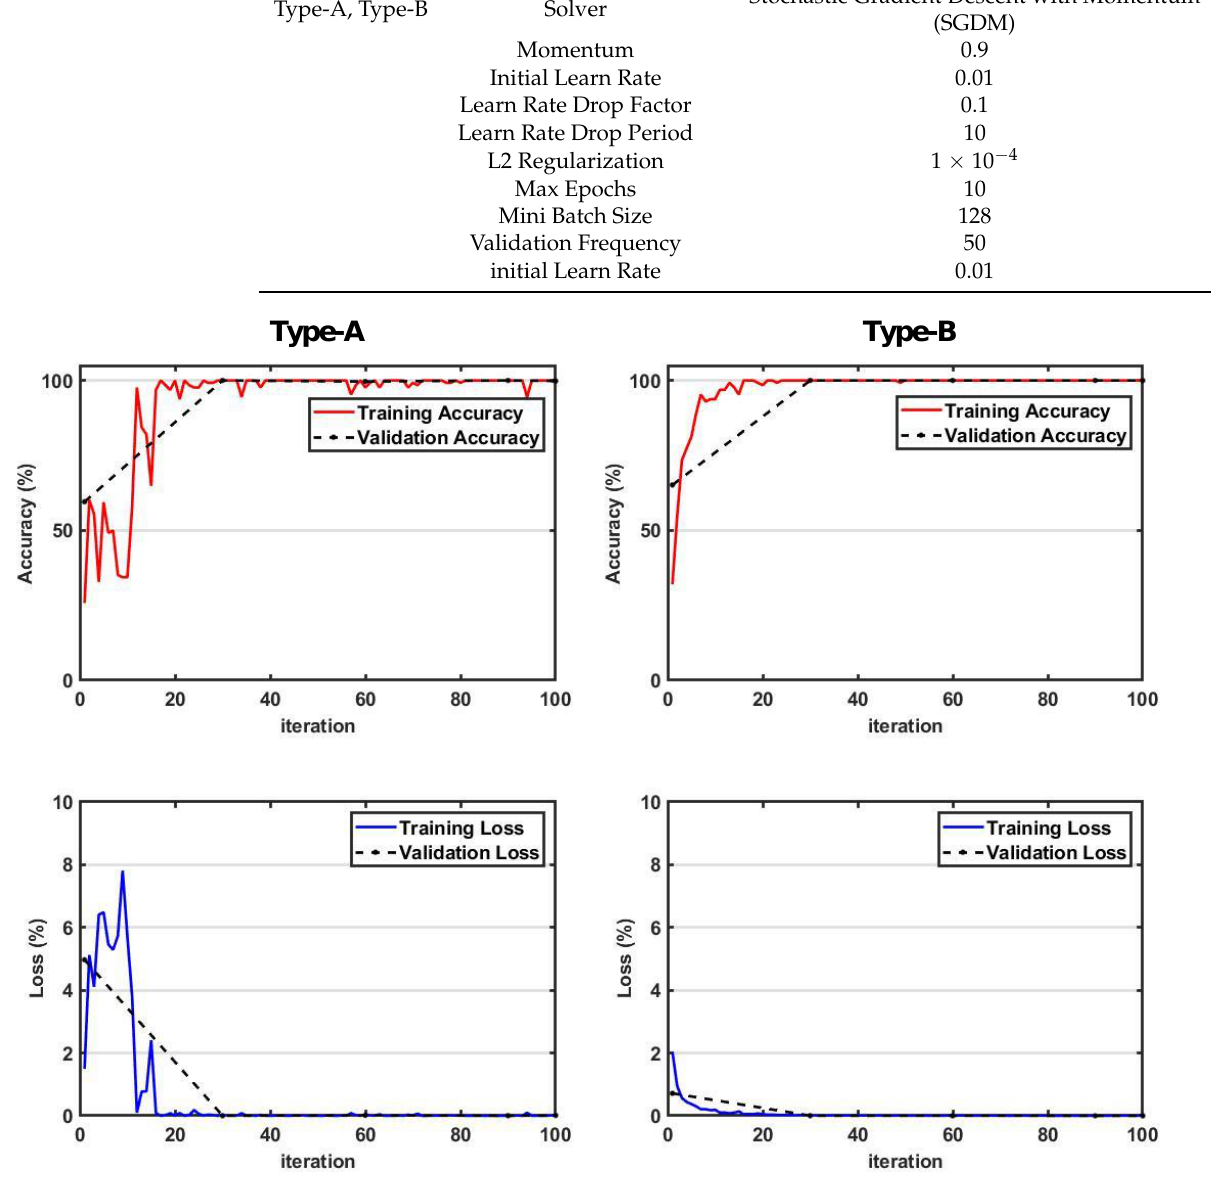
Figure 9. Comparison of accuracy and loss function for the training of two types of CNNs. ( top line) Accuracy; ( bottom line)